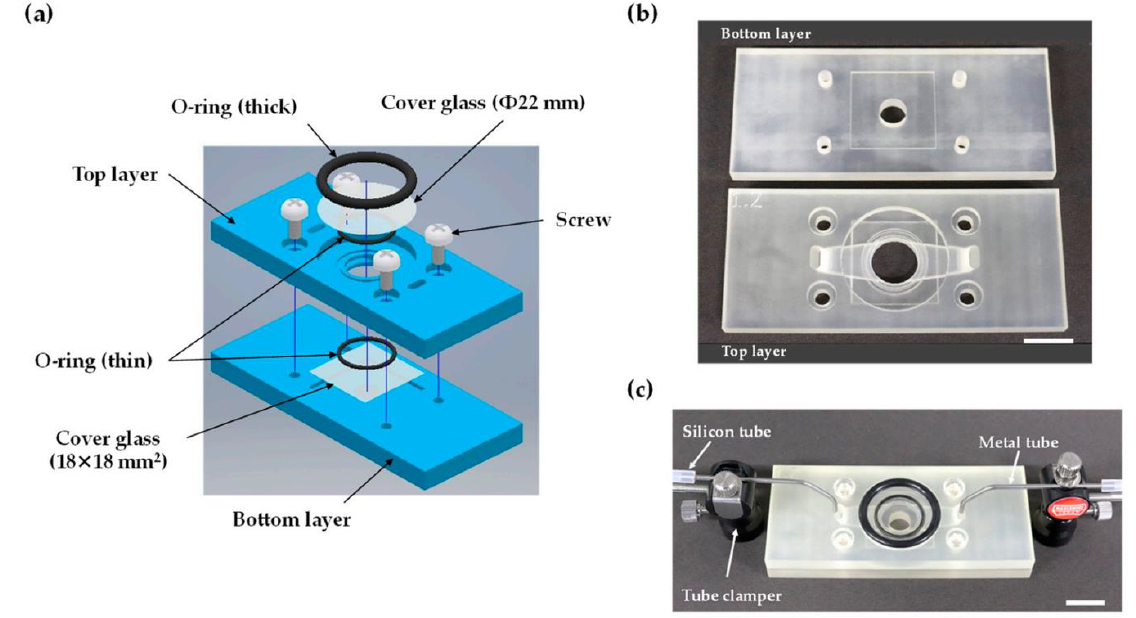
Figure 9. Design and setup of the 3D-printed perfusion cartridge system: ( a ) assembly view of the 3D-printed cartridge; ( b ) two-layer 3D-printed cartridge parts. The top layer includes flow channels and the observation area. The bottom part works as a base; ( c ) cartridge setup for assay buffer perfusion with metal tubes connected to silicon tubes and fixed by tube clampers. All scale bars are 10 mm. Reproduced with permission from Terutsuki et al. [53], Sensors, 20, 5779. Published by MDPI, 2020.